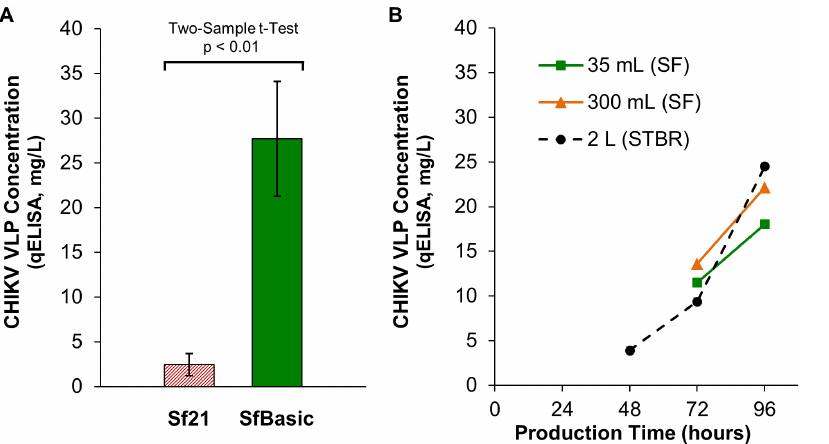
Figure 5. Volumetric CHIKV VLP yield enhancement resulting from adaptation of Sf 21 to elevated culture pH. ( A ) CHIKV VLP concentration of culture supernatants from Sf 21 and Sf Basic small-scale shake flask cultures. Error bars represent 95% confidence intervals (N=10 independent infections). ( B ) CHIKV VLP concentration of culture supernatants from scale-up of Sf Basic from shake flasks (SF) into a PID controlled 3-L stirred tank bioreactor (STBR).